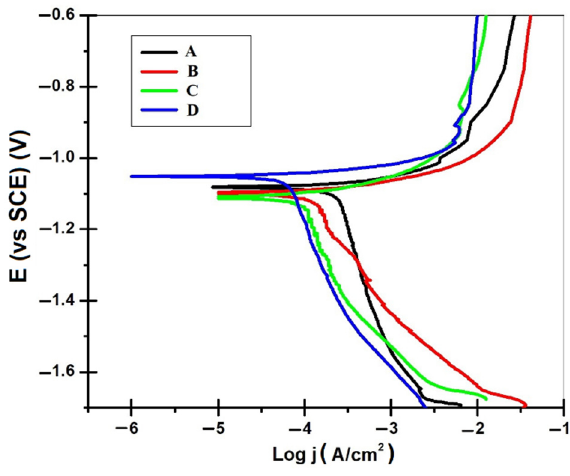
Figure 8. Open circuit potential measurements of the tested samples.